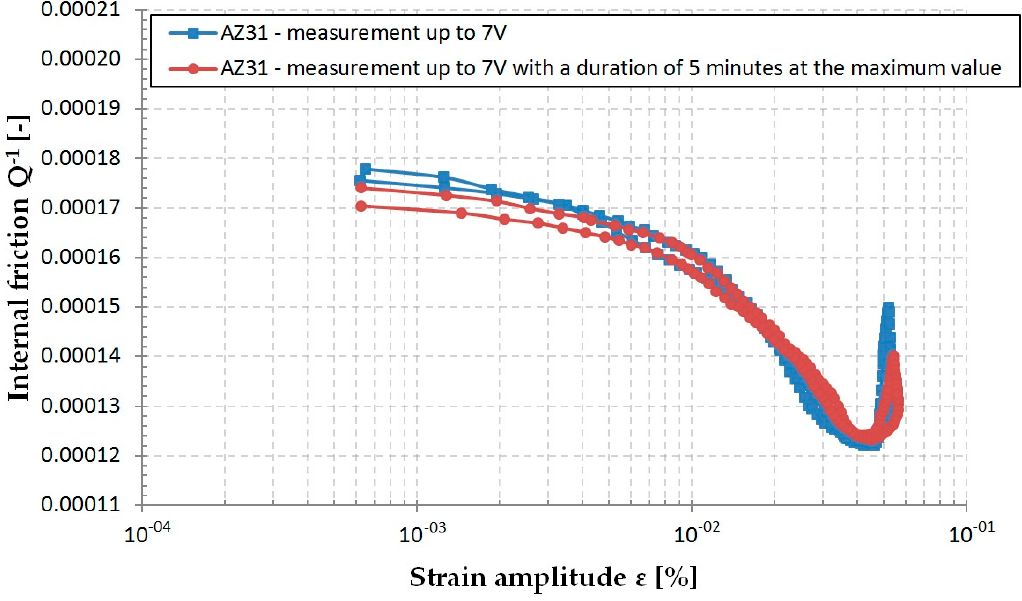
Figure 22. ADIF curve measured when the sample was held at 5 minutes on the maximum strain amplitude.